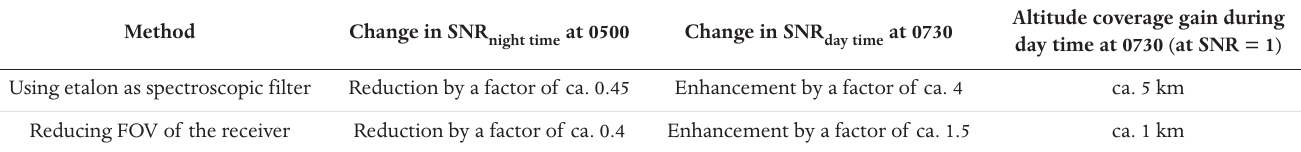
Table 2. Operational performance of two